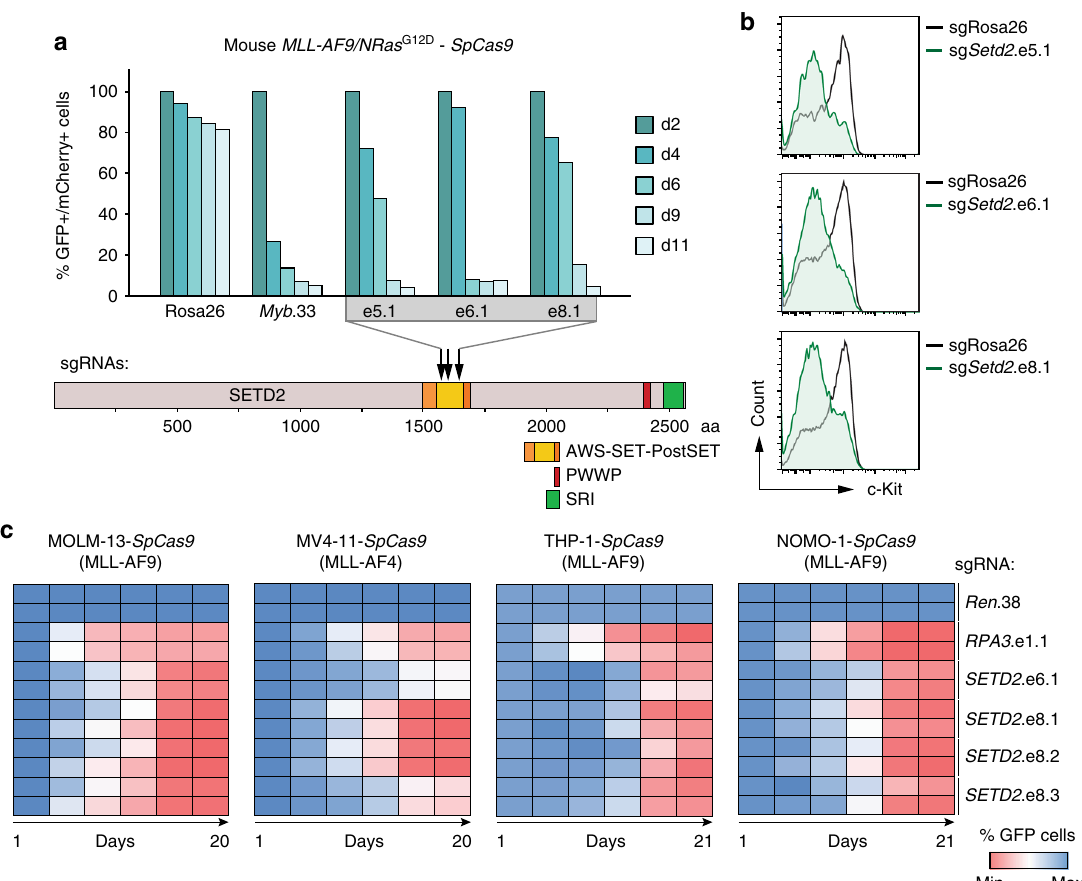
Fig. 6 The SETD2 SET domain is required for proliferation of MLL-leukemia cells. a Results of competitive proliferation assays shown as percentages of mCherry + /GFP + mouse MLL-AF9/Nras G12D- SpCas9 AML cells expressing indicated sgRNAs (top). Data from one representative experiment of two are shown. Schematic representation of the domain structure of SETD2 (bottom). b Flow cytometric analysis of surface expression of c-Kit in MLL-AF9/ Nras G12D AML-SpCas9 cells upon CRISPR/Cas9-mediated mutagenesis of SETD2 . c Heatmap representation of competitive proliferation assays shown as the percentage of GFP-positive human AML cell lines stably expressing SpCas9 cells upon CRISPR/Cas9-mediated mutagenesis of the SETD2 SET